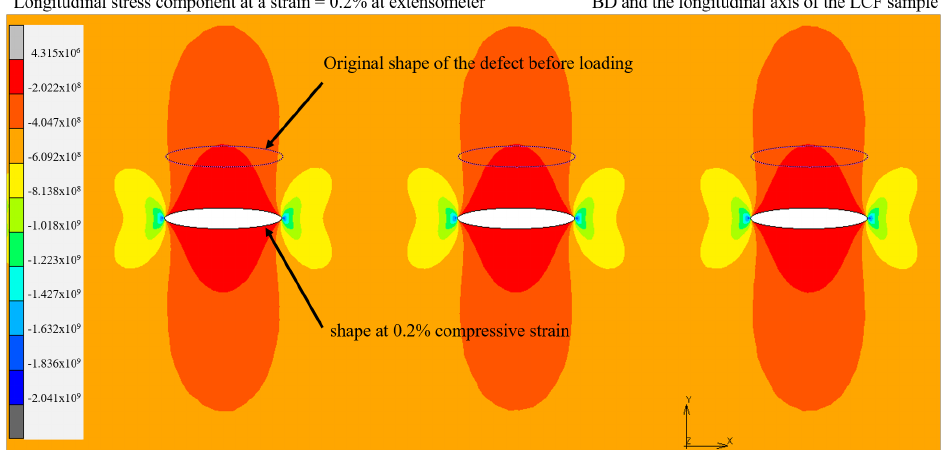
Figure A2. FE simulation